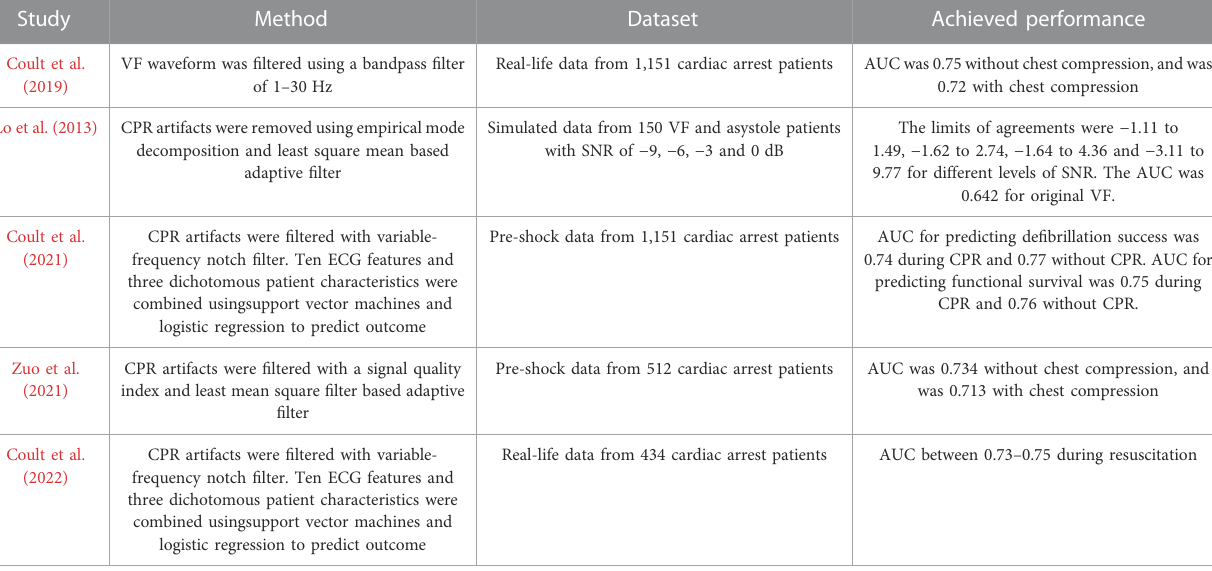
TABLE 4 Reported performance for assessment of Ventricular fi brillation prognosis in literatures. Study Method